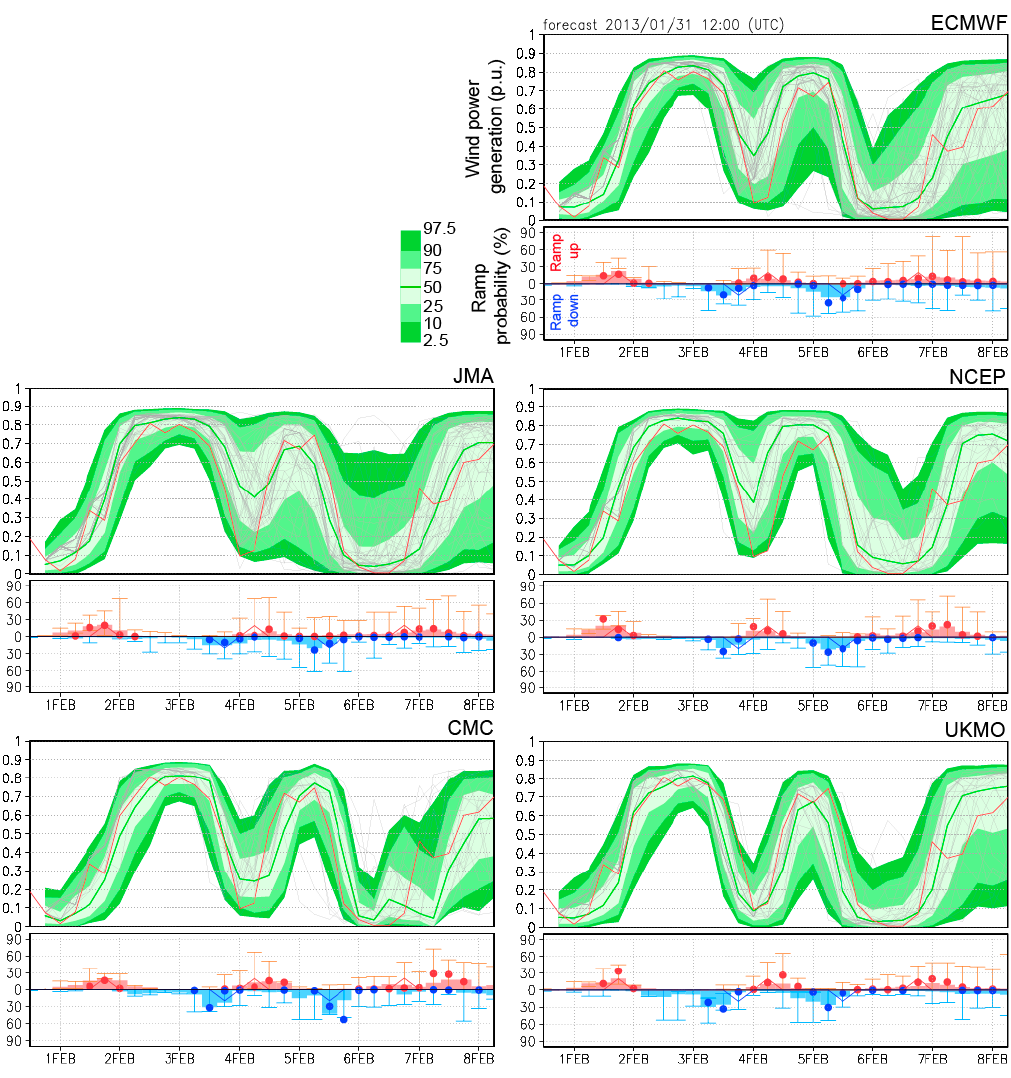
Figure 6. Same as Figure 5, except it is obtained from the five single-center ensembles with SOM-based analog-ensemble initiated from 1 January 2013, at 12:00 UTC.